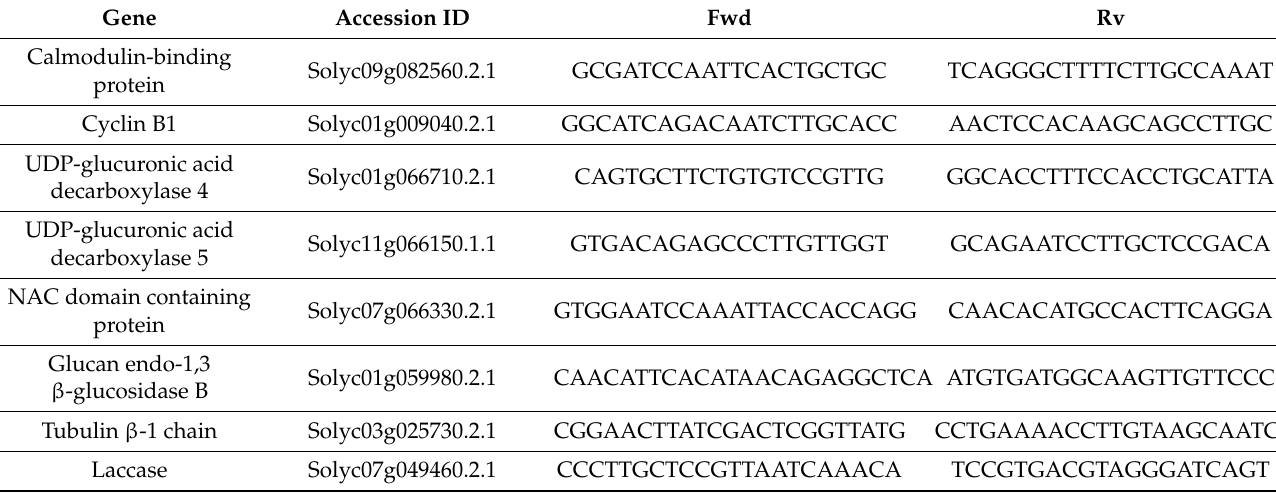
Table A3. Primers Used for qPCR of Predicted miRNA Targets.